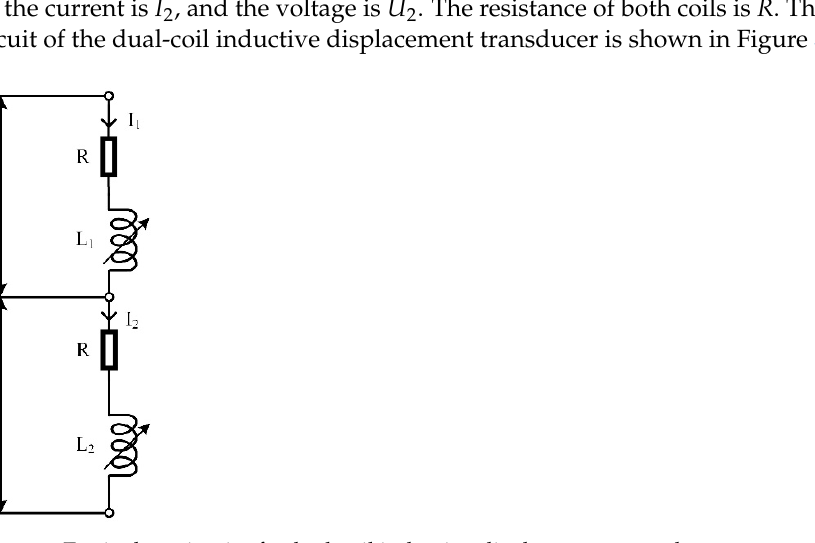
Figure 5. Equivalent circuit of a dual-coil inductive displacement transducer.